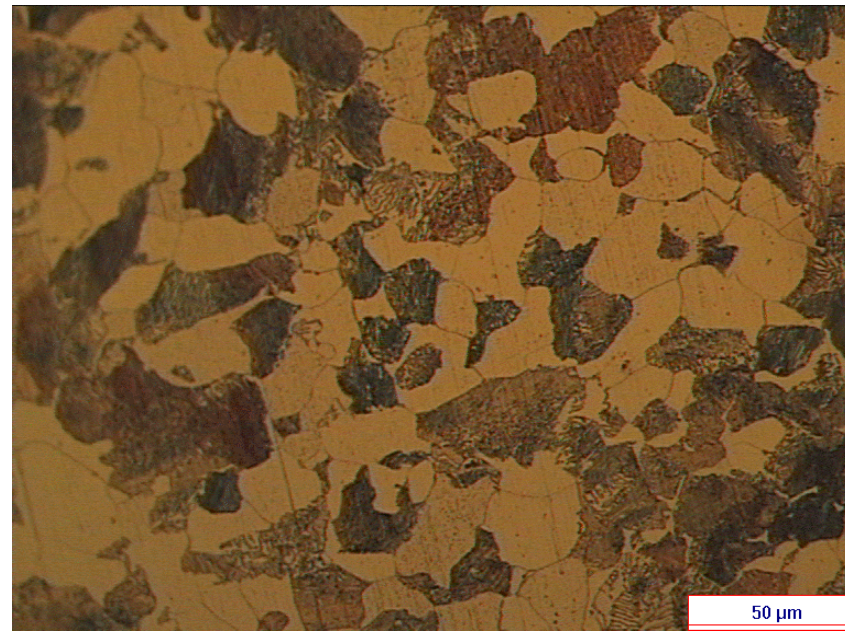
Figure 1. Microstructure of AISI 1045.